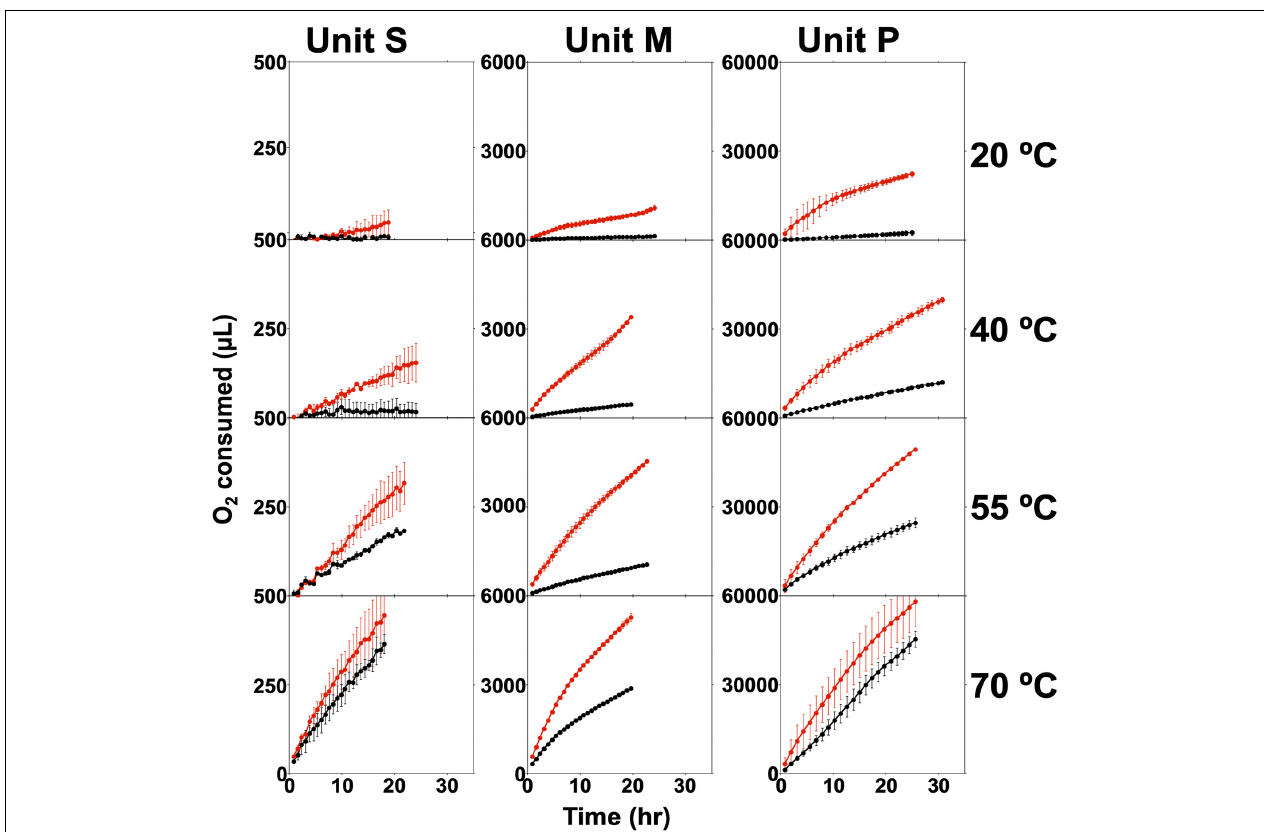
FIGURE 1 | O 2 consumption in non-sterile (red) and autoclaved (black) wFGD slurry material from Unit S, Unit M, and Unit P incubated at 20, 40, 55, and 70 ◦ C. Error bars represent one standard deviation of triplicate (non-sterile) or duplicate (autoclaved)